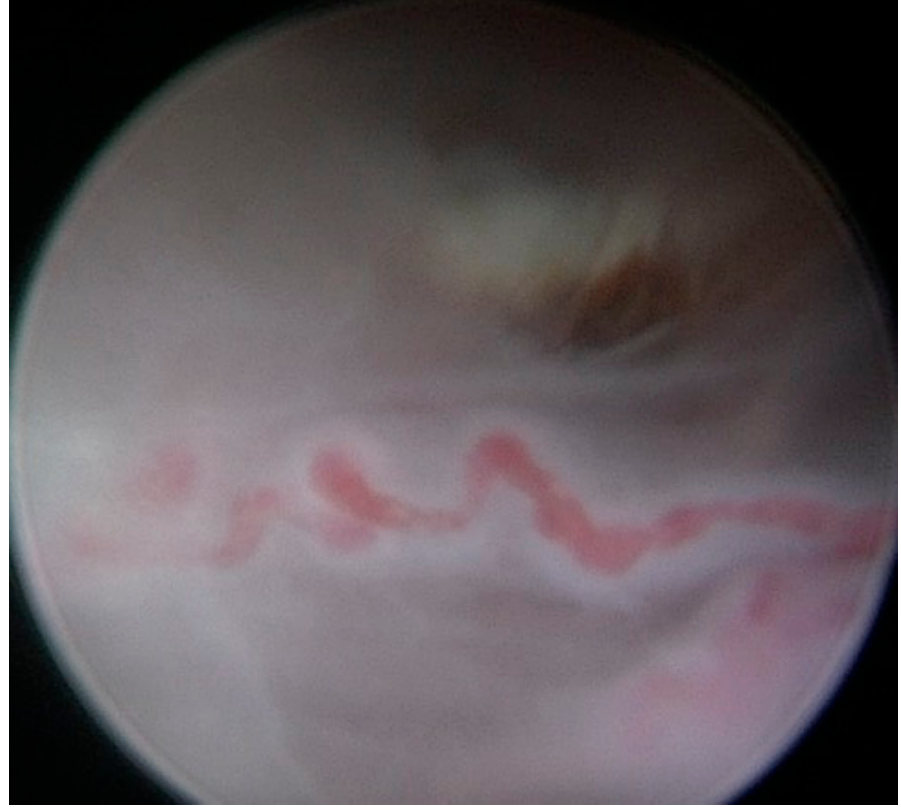
Figure 3. Hysteroscopic view of the umbilical cord.